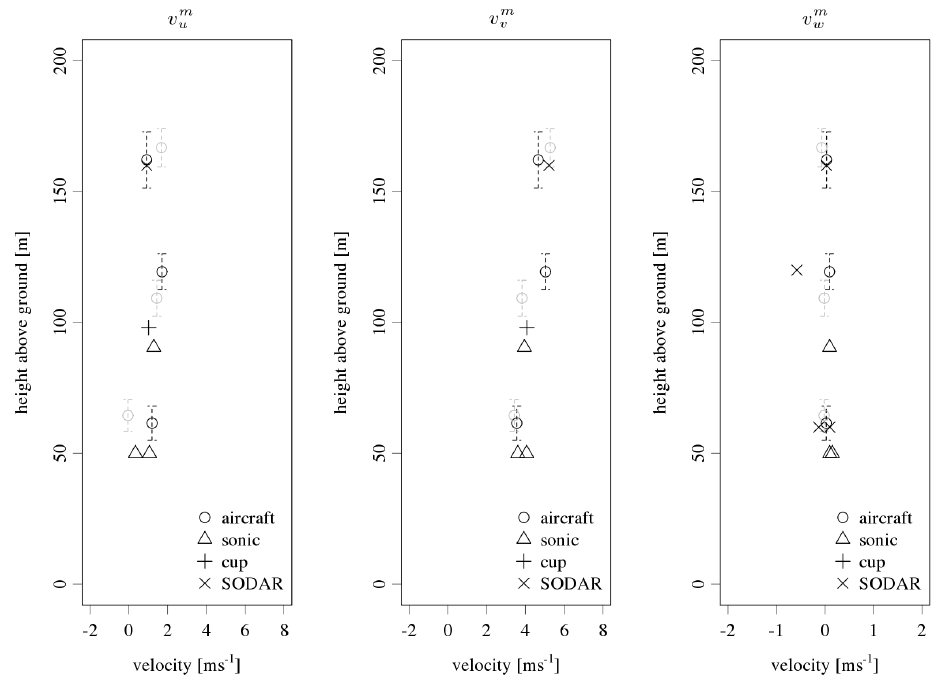
Fig. 12. Vertical profiles for horizontal ( v m uv ) and vertical ( v m w ) wind components of simultaneous ground based and weight-shift microlight aircraft measurements on 15 October 2008, 14:50–16:00CET. Different symbols indicate the different wind sensors. Black circles represent aircraft measurements at 24ms − 1 true airspeed, while grey circles represent measurements at 27ms − 1 true airspeed. Vertical error bars indicate one standard deviation of the aircraft altitude.